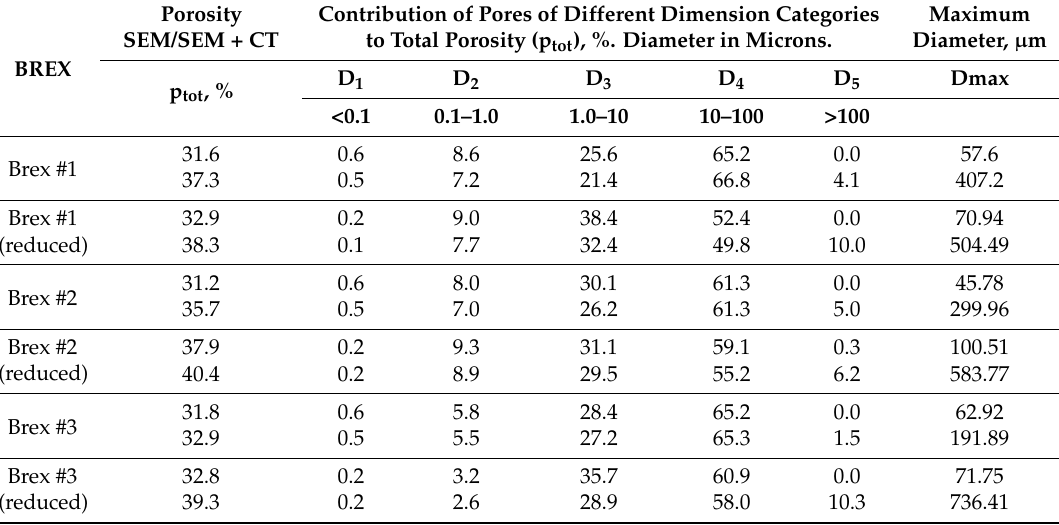
Table 6. Morphological parameters of the original and reduced brex